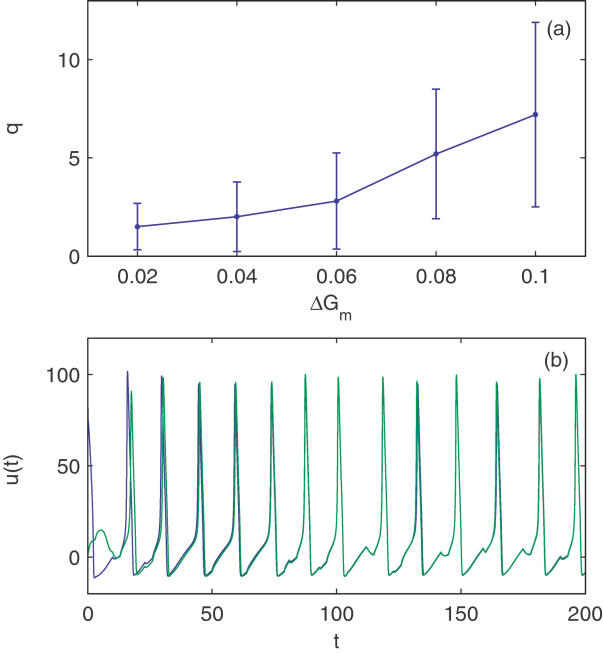
Robustness of the Mechanism with Parameter Mismatch on Gm in the HH Neuron Model.(A) The relationship between the parameter mismatch ΔGm and the synchronization error q.(B) A typical numerical result of the systems with ΔGm
 = 0.06.